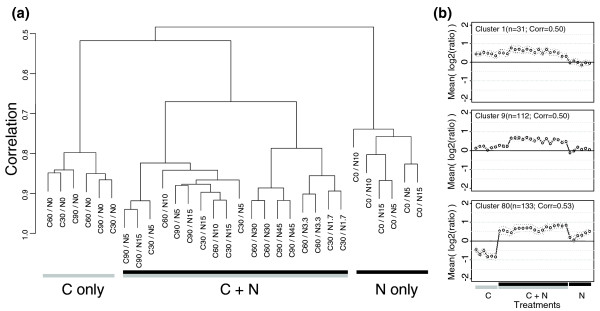
Unsupervised hierarchical clustering analysis suggests various modes of regulation by CN. (a) Hierarchical clustering distinguishes three main responses: C alone, N alone and C+N. (b) Hierarchical clustering of the gene expression patterns reveals different modes of regulation. Three representative gene expression patterns in response to the CN treatments are shown. The mean expression ± 95% confidence interval of the mean for all genes in the cluster is plotted.